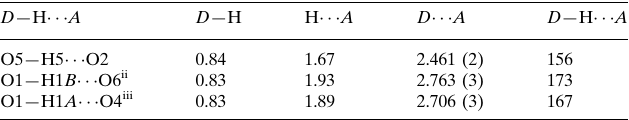
Hydrogen-bond geometry (A˚ , (cid:2)